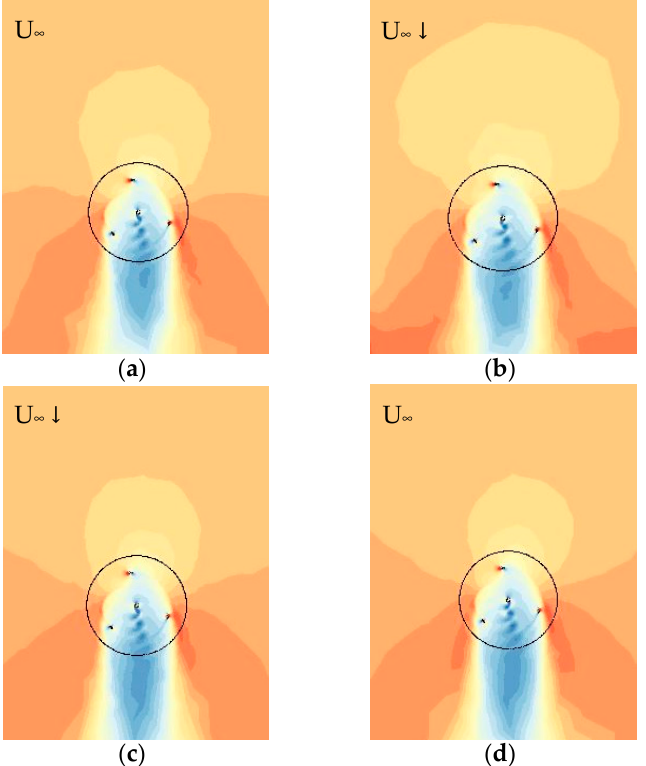
Figure 16. Velocity contours around center turbines of ( a ) 2 rotor distance, ( b ) 4 rotor distance, ( c ) 8 rotor distance and ( d ) 12 rotor distance.